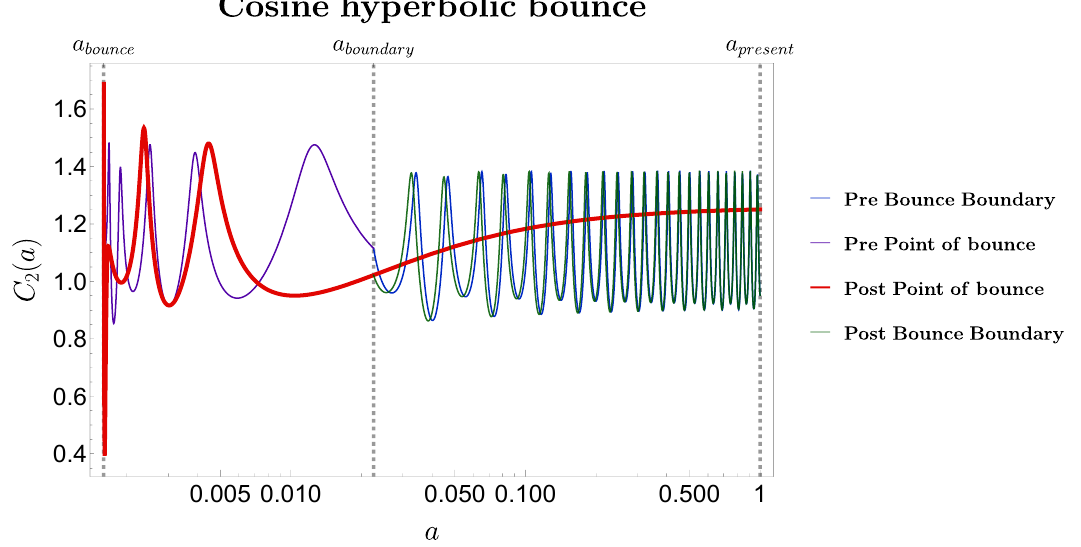
Figure 13: Geodesically weighted Complexity value at different regions plotted against scale factor.